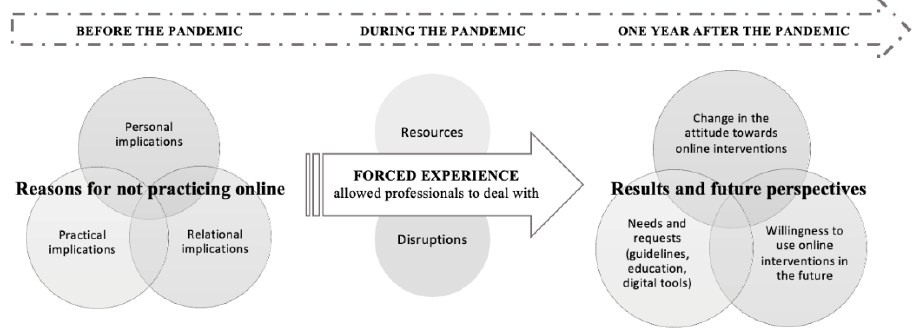
Figure 2. A graphic representation of the effects that the COVID-19 pandemic had on Italian psychologists’ and psychotherapists’ attitudes towards online interventions.